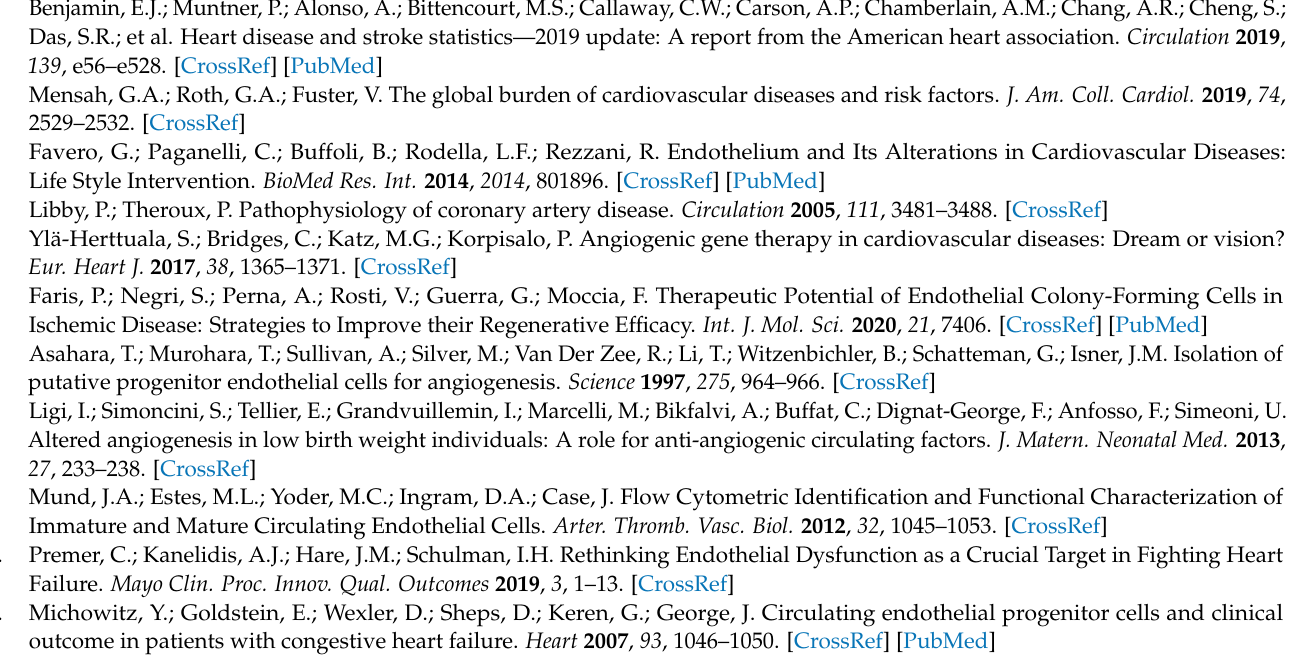
Figure S2. Mevalonate (200 µ M) modulates pravastatin’s effect on ECFCs’ tube formation ability. Representative images of ECFCs’ tube formation after 6 h in the presence of medium only